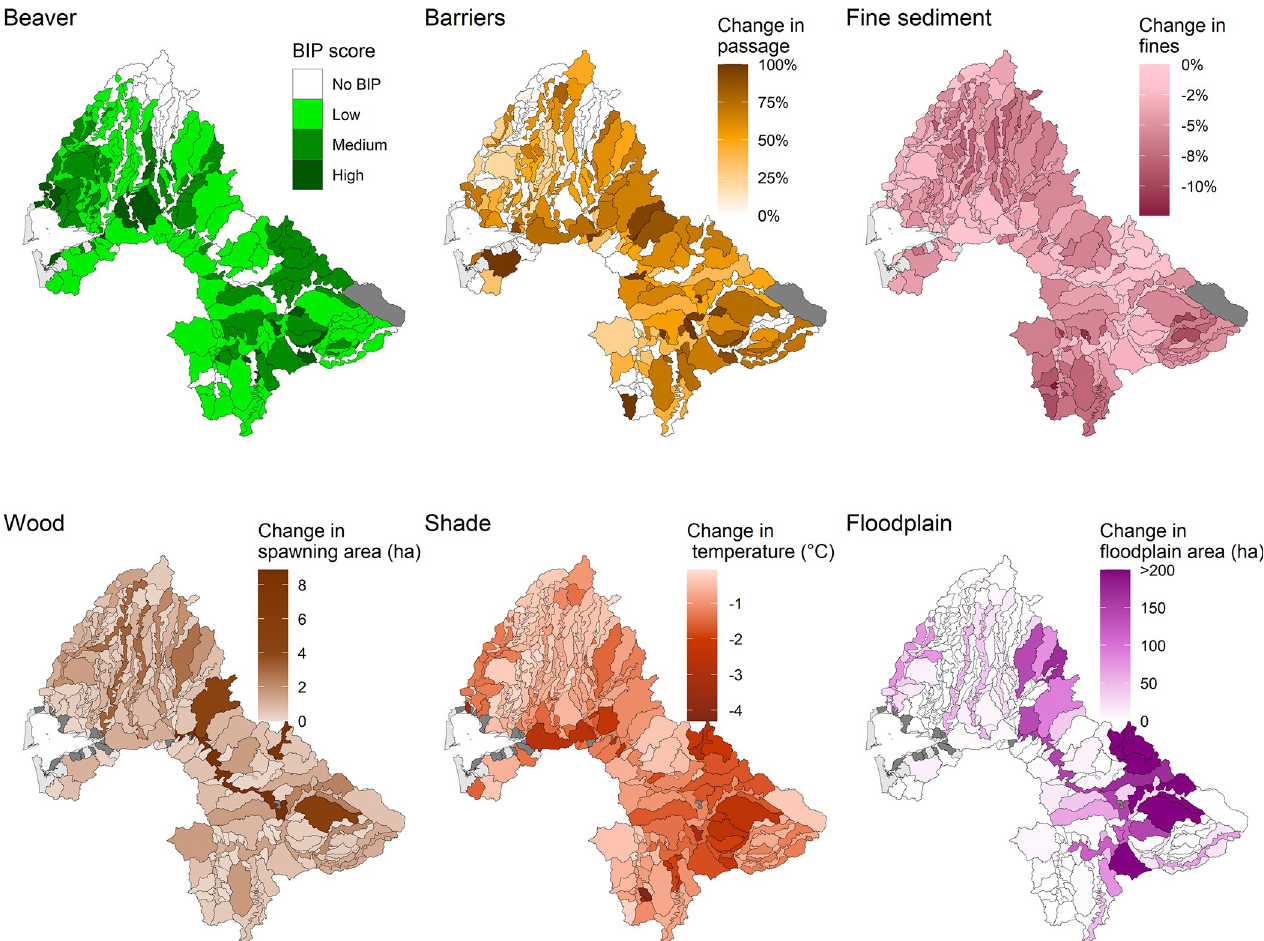
Fig 7. Spatial distribution of restoration potentials. Maps of restoration potential for six habitat attributes under current climate conditions and development, indicating spatial variation in restoration potential without effects of climate change or future development. Beaver is the mean beaver intrinsic potential score by Geospatial Unit (GSU). Barriers is the potential increase in mean passability percentage by GSU if migration barriers are removed. Fine sediment is the potential decrease in fine sediment if forest road surface erosion is reduced (mean historical percent fines–mean current percent fines). Wood is the potential increase in hectares of spawning gravel by GSU via increasing wood abundance (historical spawning gravel area–current spawning gravel area, in hectares). Shade shows the stream temperature restoration potential ( Δ ˚C) by GSU via riparian shade restoration (mean historical ˚C–mean current ˚C). Floodplain indicates the potential increase in hectares of floodplain habitat area by GSU via restoration of floodplain connectivity (historical ha–current ha of floodplain habitat).